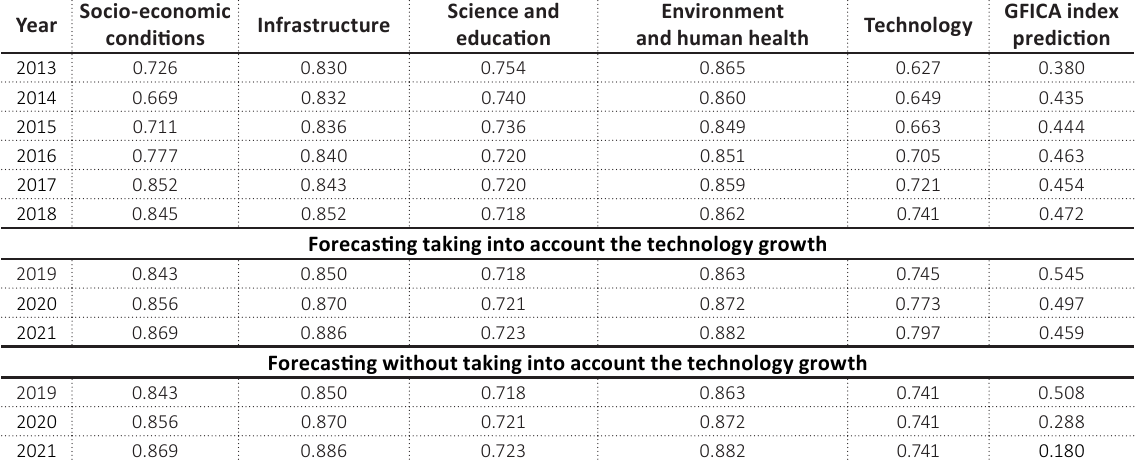
Table 4. Estimated and forecasted values of the components of Ukraine’s investment potential based on the Hurst exponent in 2013–2021